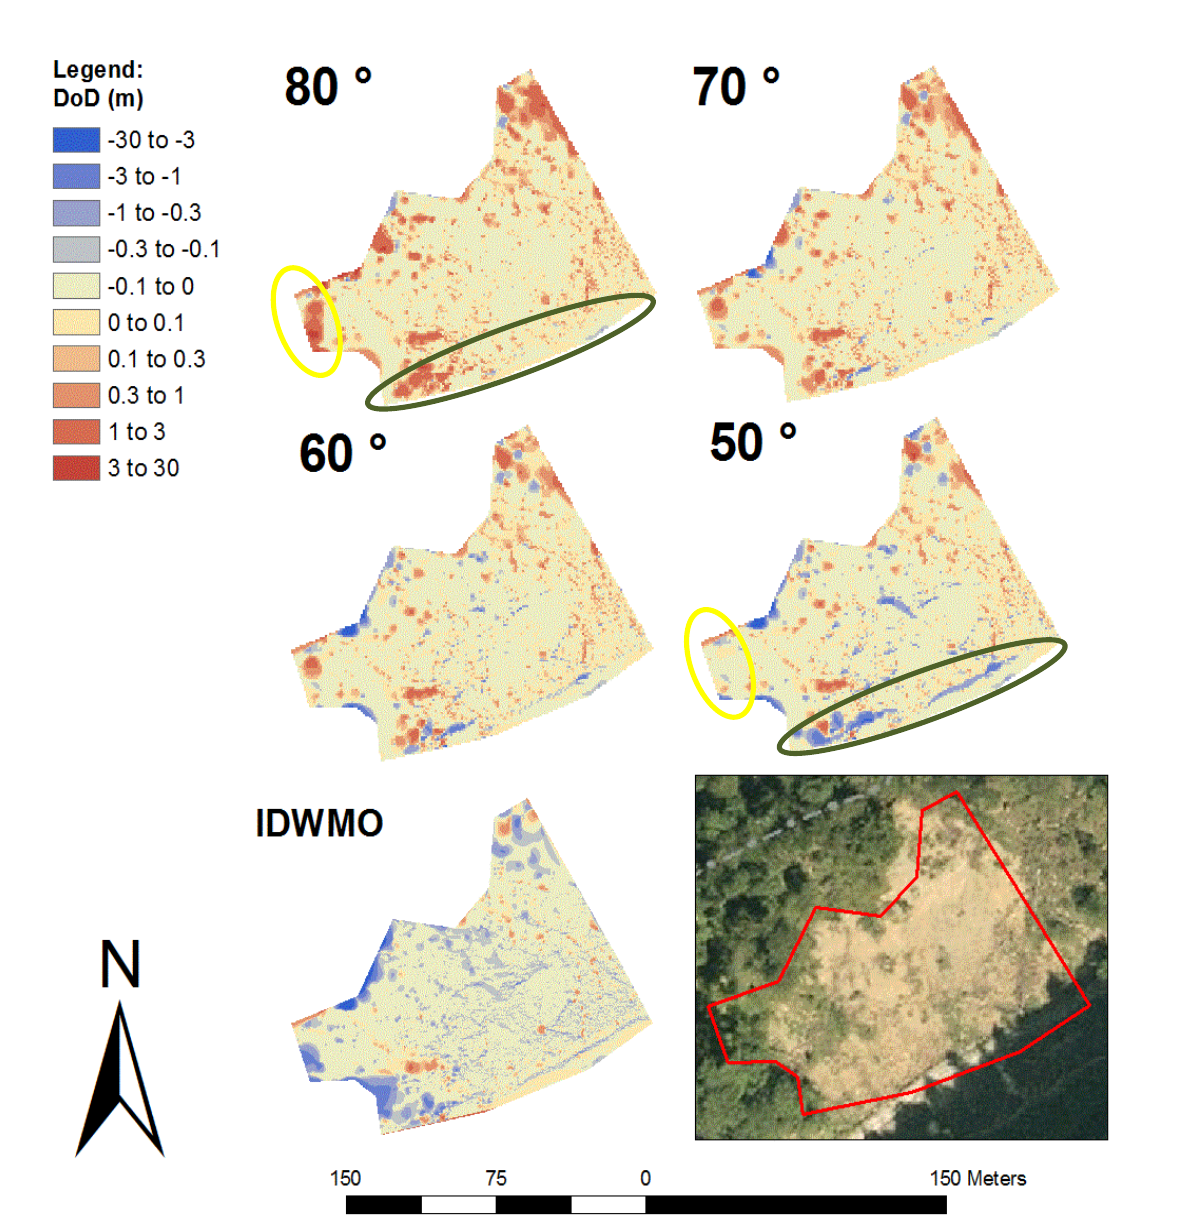
Figure 12. Differences of the second test area between the new calculated terrain models (filter angles 80, 70, 60 and 50 degrees) and the manually filtered terrain model (m).